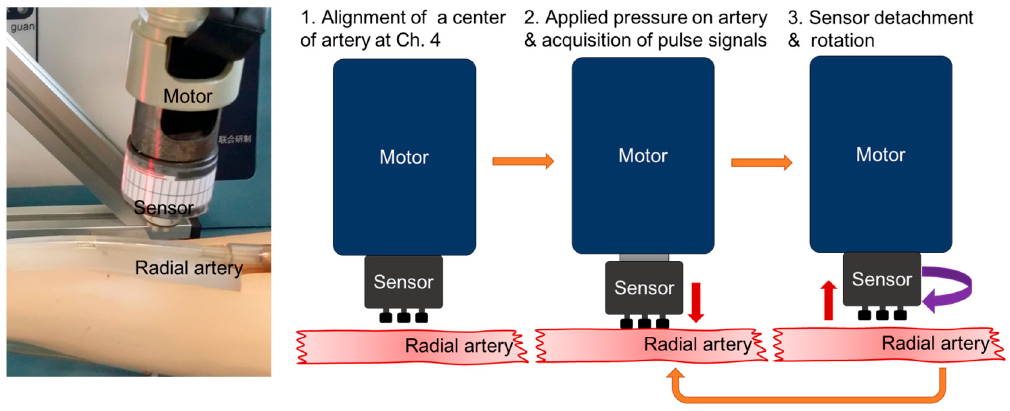
Figure 10. Experimental sequence for estimating blood vessel direction on the artery model in the simulator.